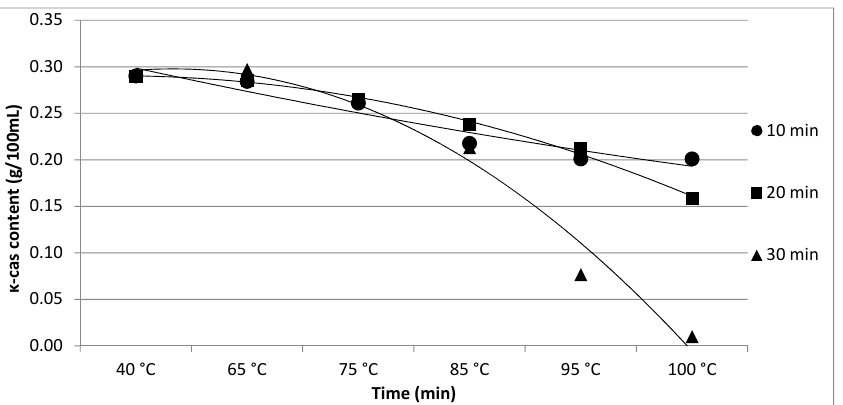
Figure 2. Effect of heating time and temperature on β -cas content. Equations: 10 min (y = 0.0004x 2 + 0.0055x + 0.9329; R 2 = 0.8644), 20 min (y = − 0.0076x 2 + 0.1184x + 0.8358; R 2 = 0.9522), 30 min (y = − 0.0251x 2 + 0.2711x + 0.6698; R 2 = 0.9861).